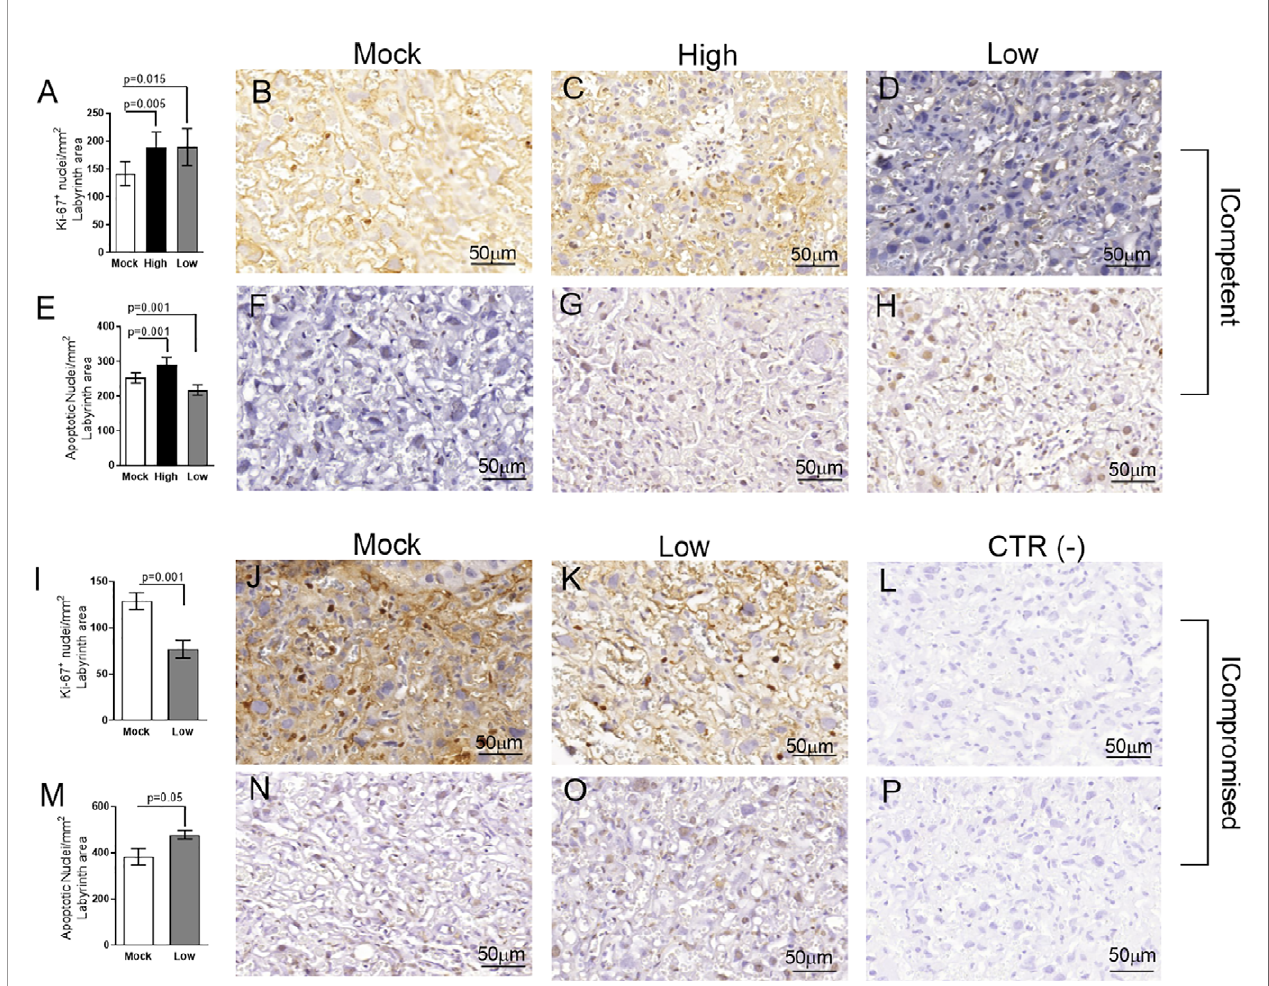
FIGURE 4 | Labyrinthine remodeling in ICompetent and ICompromised placentae is affected by gestational ZIKV infection. A total of 180 digital images (40X) randomly captured from the whole labyrinth zone (Lz) of each placenta per dam were evaluated. Immunolabeled nuclei from each digital image were quanti fi ed and normalized by the total digital image area to obtain an index of the estimated number of proliferative and apoptotic nuclei in the entire histological section. (A, I) Quanti fi cation and (B – D, J, K) representative photomicrographs of Ki-67 + stained nuclei in the Lz of ICompetent (n=6 placentae from 6 independent dams/group) and ICompromised (n=3 placentae from 3 independent dams/group) placentae, respectively. (E, M) Quanti fi cation and (F – H, N, O) representative photomicrographs of apoptotic nuclei (TUNEL) in the Lz of ICompetent (n=5 placentae from 5 independent dams/group) and ICompromised (n=3 placentae from 3 independent dams/ group) placentae, respectively. (L, P) Negative controls. One-way ANOVA followed by Tukey ’ s posttest was used to assess changes among ICompetent groups, whereas an unpaired Student ’ s t-test or nonparametric Mann-Whitney test was used to assess differences between ICompromised groups. The values are expressed as the mean ± SEM. Images were captured at 40X. Scale bar=50